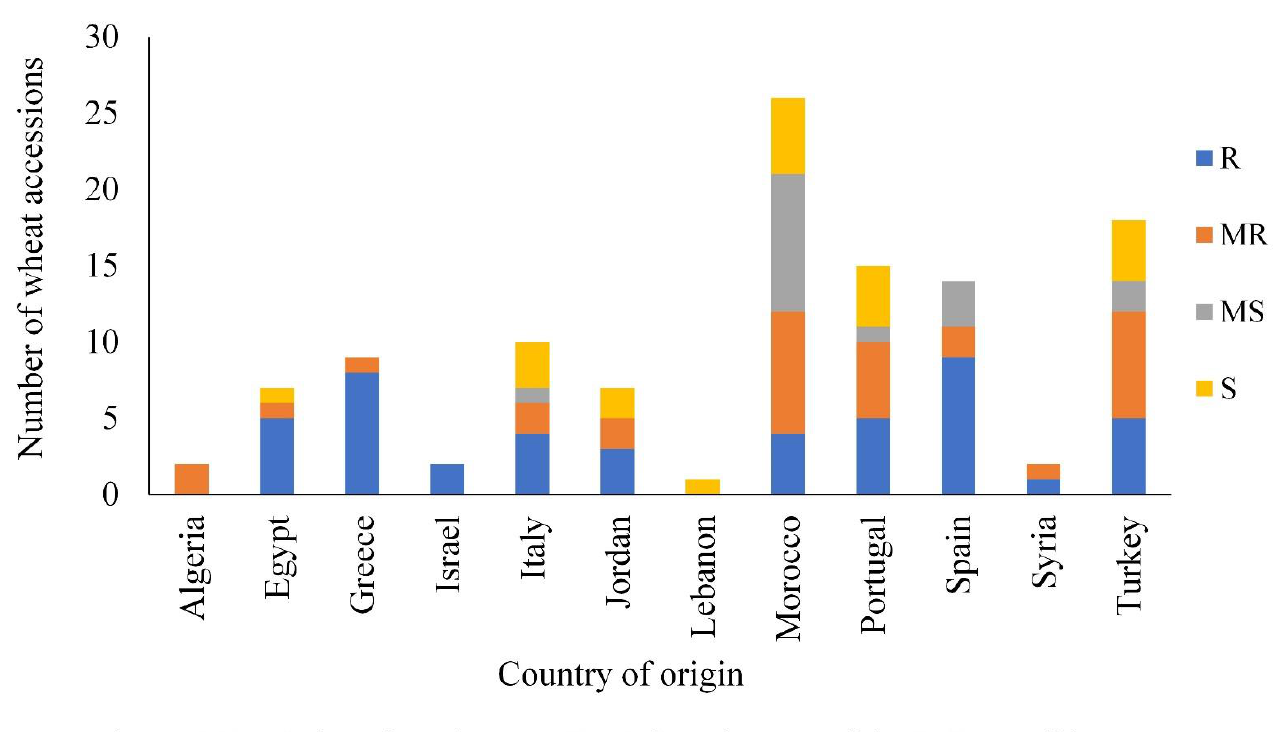
Figure 5. Resistance levels of 113 durum wheat accession’s reactions to tan spot disease in-field at the adult stage among Figure 5. Frequencies of resistance levels (%) of 113 durum wheat accession’s reactions to tan spot disease in-field at the countries of origin in the 2018–2019 cropping adult stage among countries of origin in the 2018–2019 cropping season.